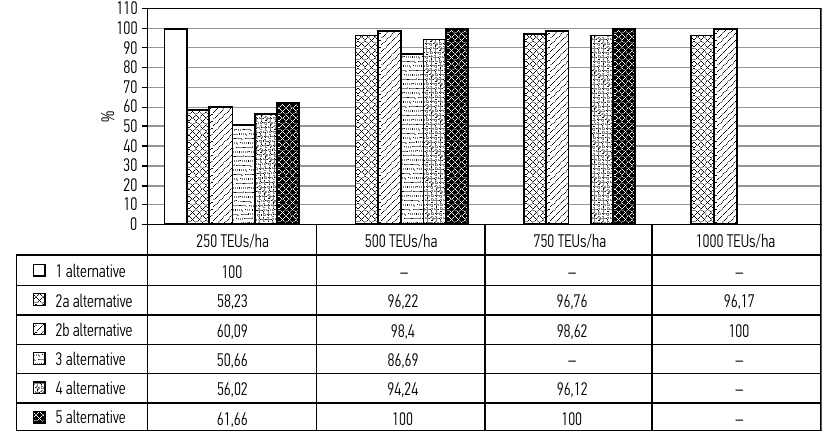
Fig. 3. The utility degree of the compared technologies and the possibilities of application according to storage